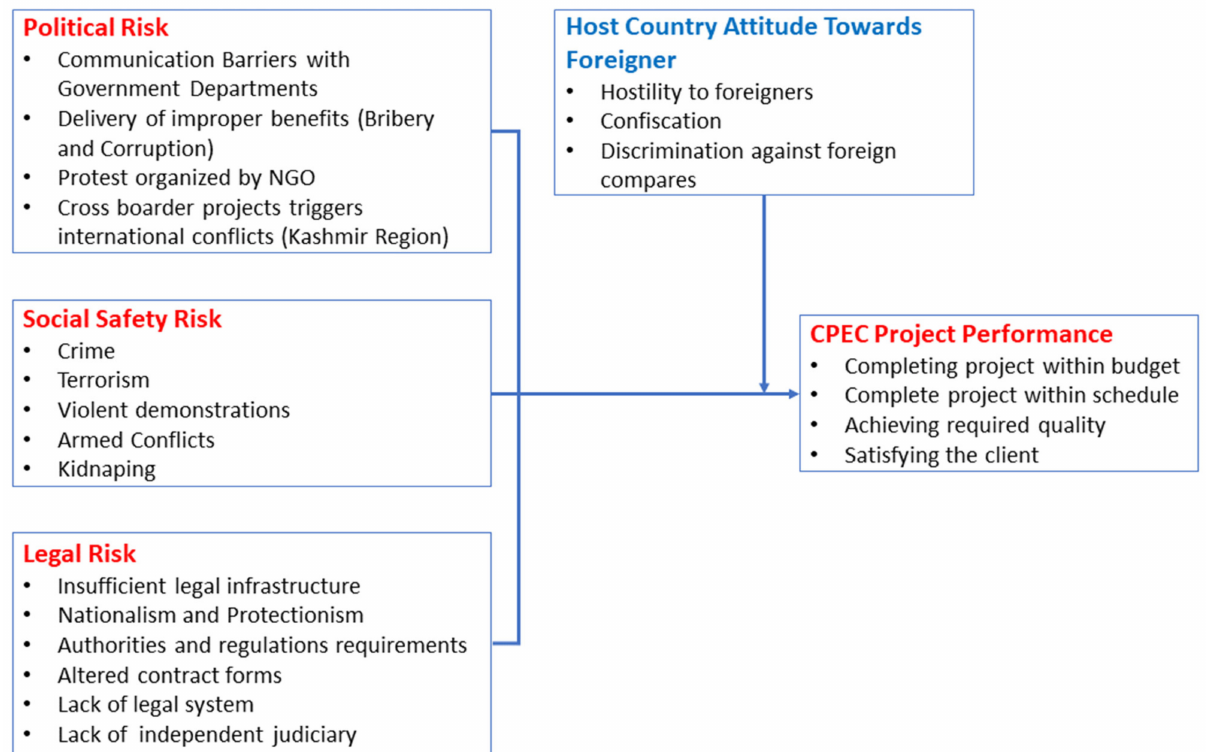
Figure 1. Research framework for studying risk factors associated with